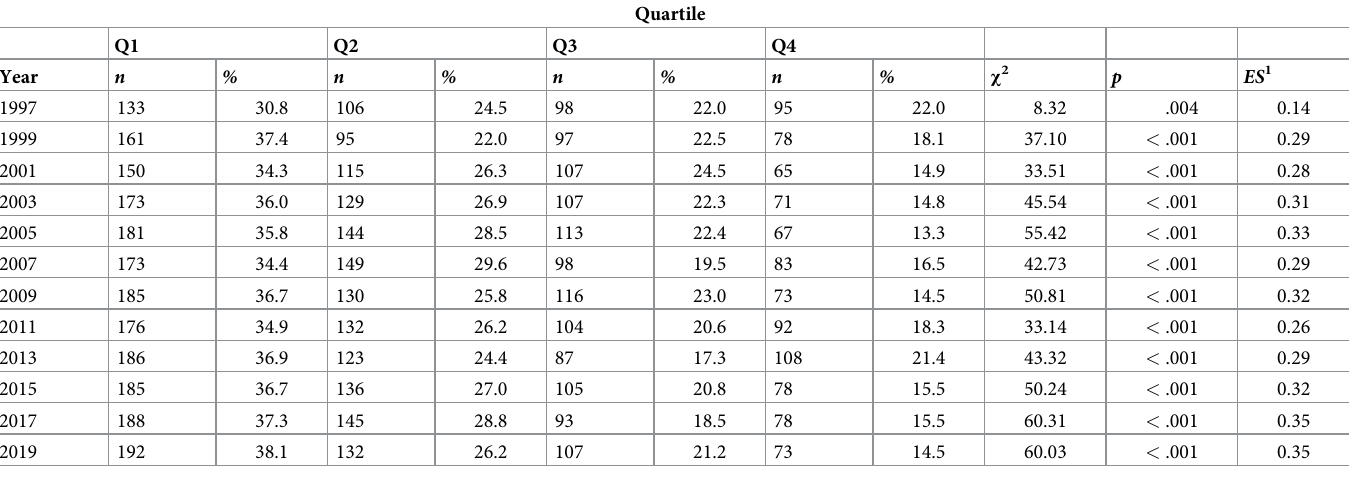
Table 4. Distribution of birth dates in male soccer players participating in under-20 world cup 1997–2019.